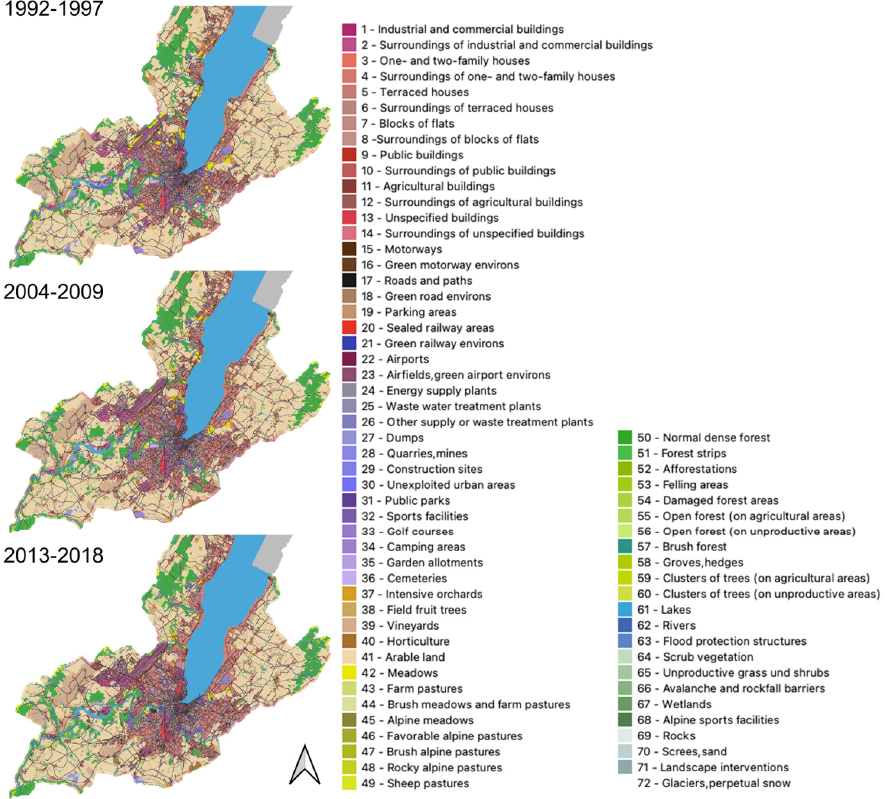
Figure 6. Land use downscaling from 100 m to 25 m and overlay of linear features for state of Geneva for the three periods. The average percentage of similarity for the three periods evaluated between the original points found in the Landuse100 statistics and the resulting Landuse25 classifica- tions is 71% when assessed without roads, rivers, and rails, and 68% when assessed with these linear features. Several categories have a correspondence of 70% or greater. Overall F1-scores and kappa coefficient are high (0.69 and 0.67, respectively). Individual classes F1-scores range from 0.007 to 0.98 depending on the category (Figure 7). Weighted mean F1-scores per dataset range from 0.67 to 0.70. Kappa scores range from 0.65 to 0.69. Cate- gories from the Landuse100 classification that show zero correspondence are those that were not predicted, such as flood protection structures (63), field fruit trees (38), or grooves and hedges (58), and were thus discarded from the validation analysis. The cate- gories that are best respected by the downscaling are those that have a large spatial rep- resentation and those that were imposed from the topographic map.